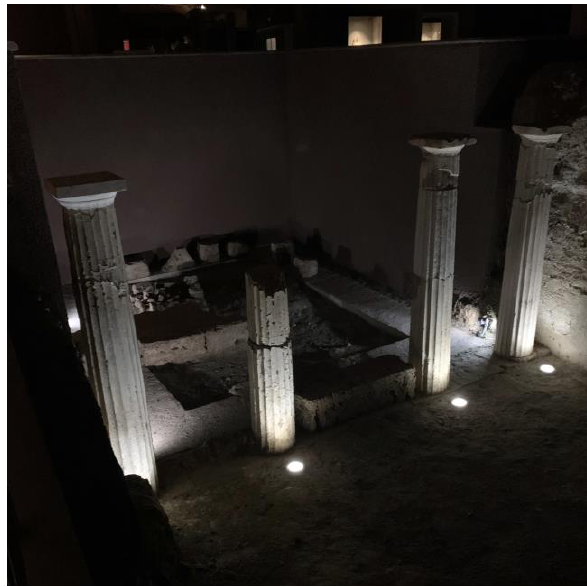
Figure 2. View of the Tomb of Philip II. Photos by the authors.